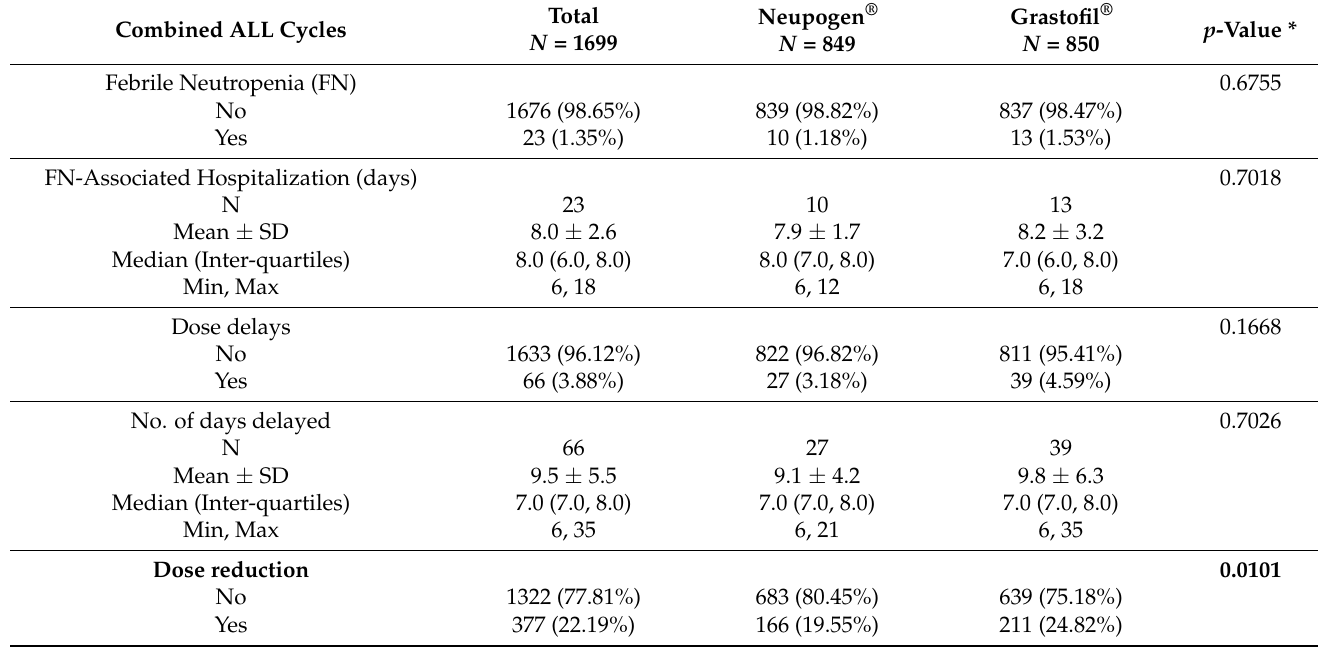
Table 5. Combined Cycle Breast Cancer